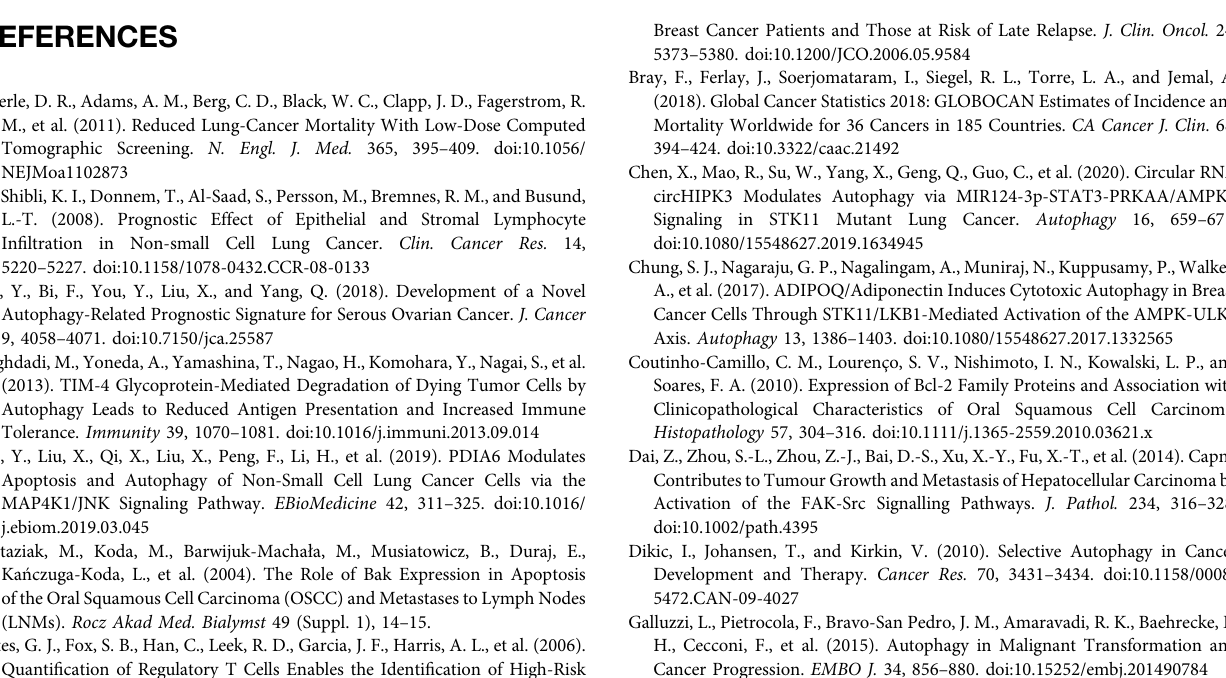
Supplementary Figure S1 | Expression levels of fi ve prognostic ARGs and prognosis in LUAD patients according. (A,B) BAK1 and SPHK1 were highly expressed in LUAD compared with normal lung tissues. (C – E) CAPNS1, CCR2 and CTSD were down regulated in LUAD compared with normal lung tissues. (F – I) BAK1, CAPNS1, CCR2 and SPHK1 showed their prognostic value. (J) CTSD (also named CLN10) expression level seems have no relationship with OS in LUAD. LUAD, lung adenocarcinoma; OS, overall